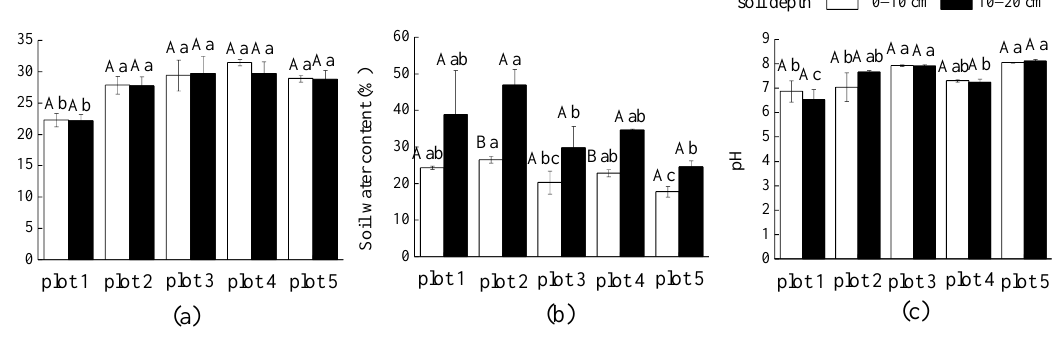
Figure 1. Soil temperature (a), water content (b) and pH value (c) of Z. planispinum plantations with different planting combinations. Plot 1, Z. planispinum + P. salicina ; plot 2, Z. planispinum + S. tonkinensis ; plot 3, Z. planispinum + A. hypogaea ; plot 4, Z. planispinum + L. japonica ; plot 5, Z. planispi- num monoculture plantation. The vertical line on each bar is the error line, that is, the error range of the statistical results. The upper part is a positive error, and the lower part is a negative error. Lower case letters indicate significant differences between different plantation types of the same depth at p < 0.05; upper case letters indicate significant differences between different depths of the same plantation types at p < 0.05. One-way ANOVA was used to calculate the differences, p = 0.05, n = 15.